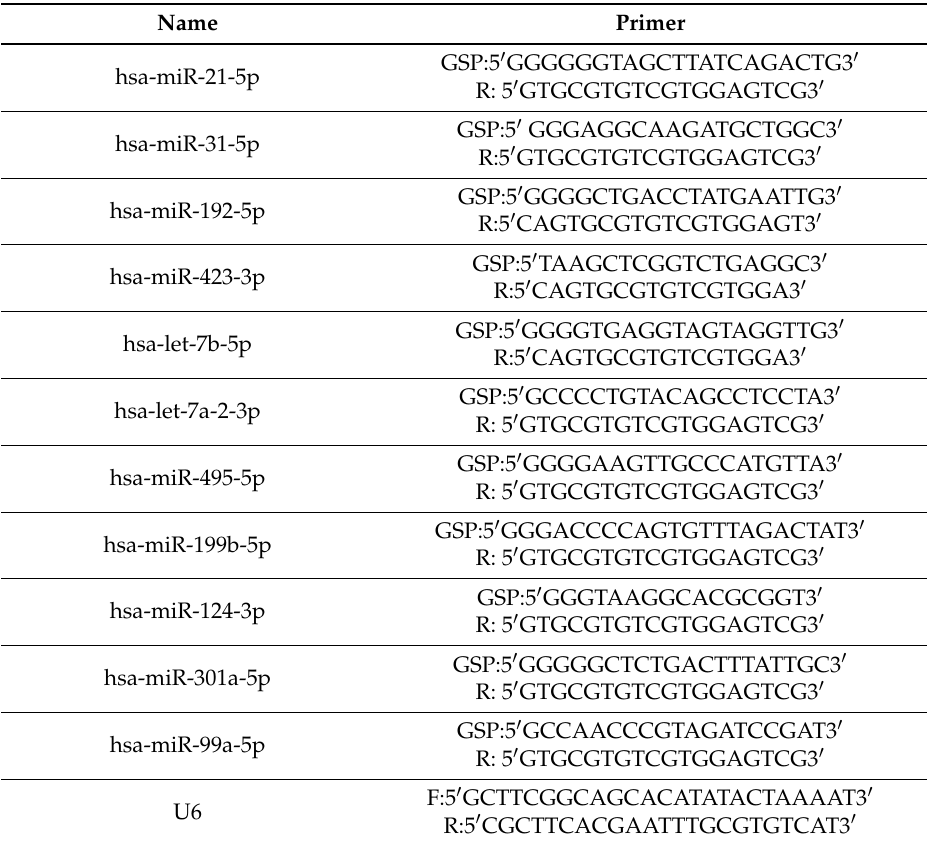
Table 1. Primers used for quantitative real-time